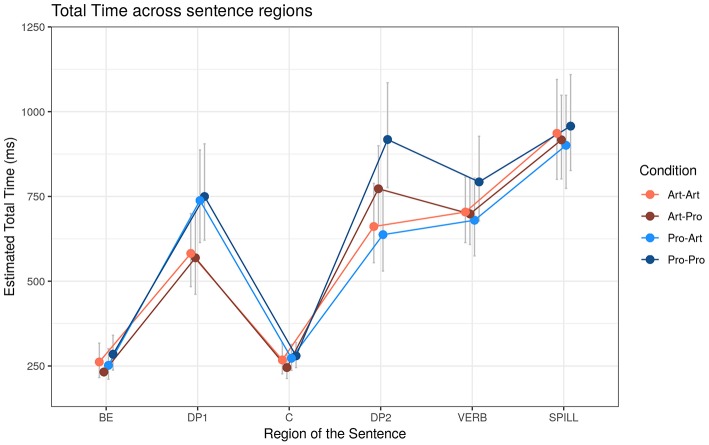
Estimated Second Pass (SP) reading times (ms) across sentence regions. Error bars represent 95% confidence intervals around the models' estimates.